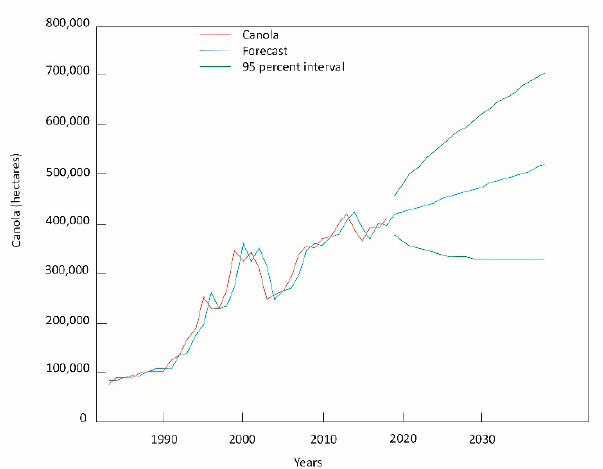
Figure 3. Prediction of canola development in Czech Republic to 2040.